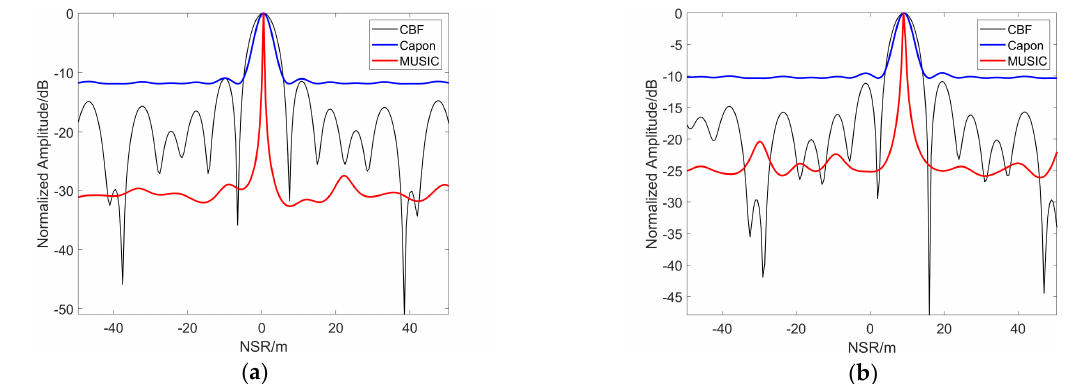
Figure 20. Moving point result ( v x = 0.1 m/s) with baseline number 10: ( a ) 1st point; ( b ) 55th point.